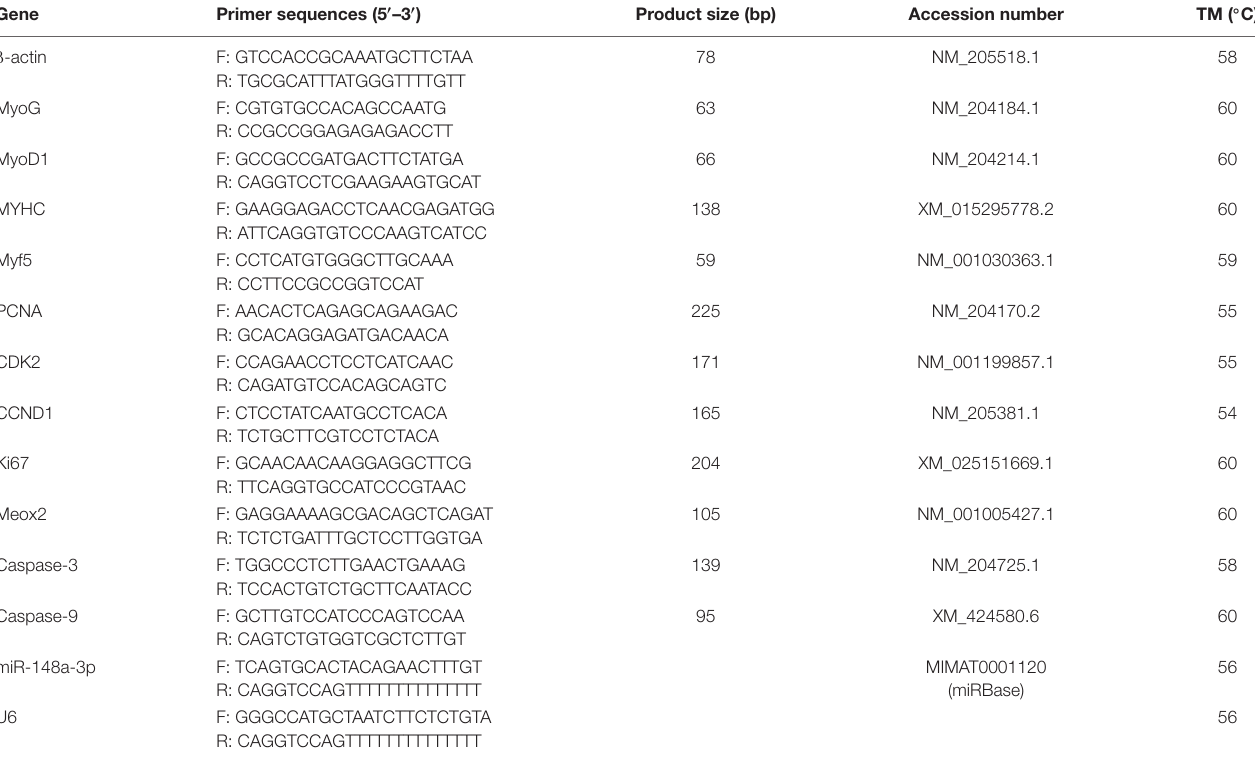
TABLE 2 | Primers used for quantitative real-time